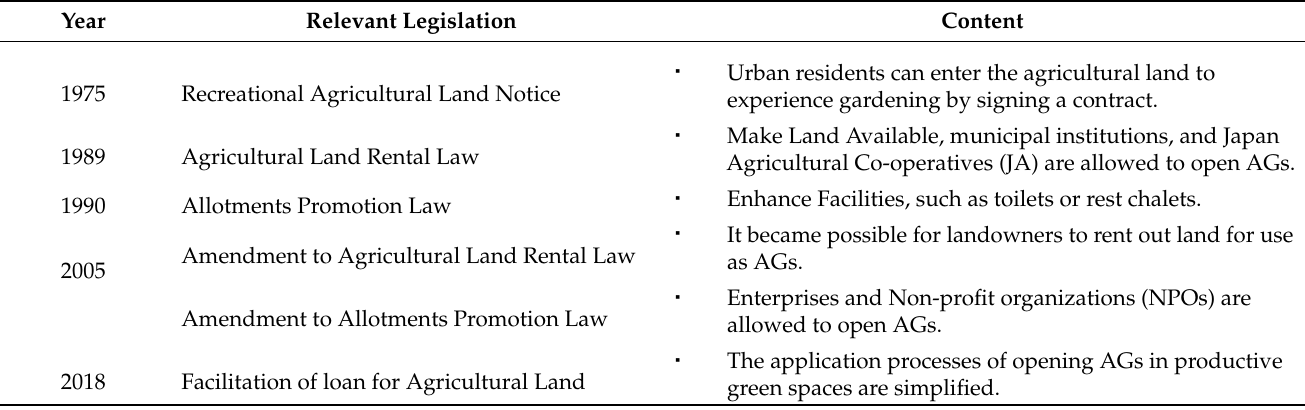
Table 1. Relevant legal basis for the provision of AGs in Japan.